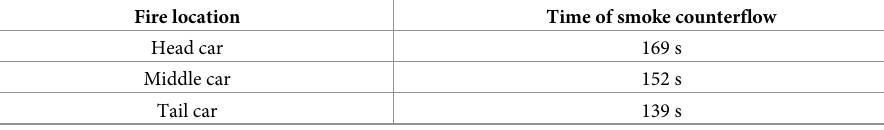
Table 3. Time of smoke counterflow for different fire sources.